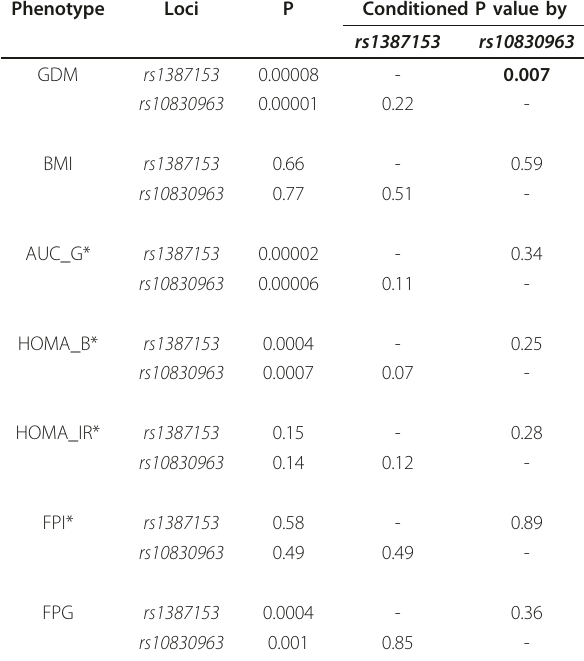
Table 6 Conditional association analyses of MTNR1B genetic variants